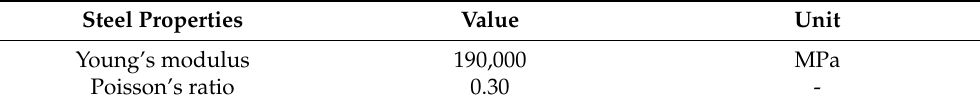
Table 3. Elastic constants of the material model of fasteners.